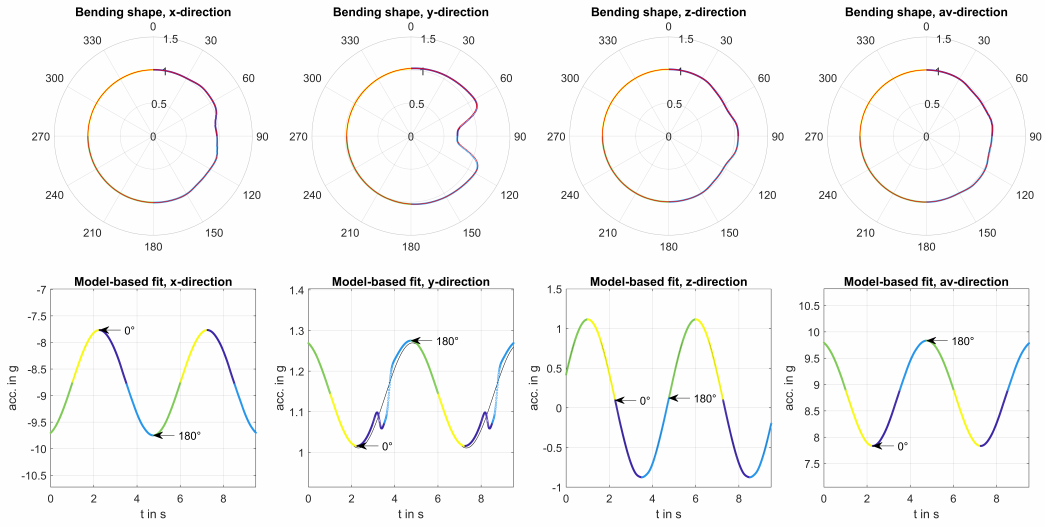
Figure 8. Bending shapes for simulated tower shadow for sensor mounting at β = 0° = γ = 0° and R = 55m at a rotation frequency of f 0 = 0.2